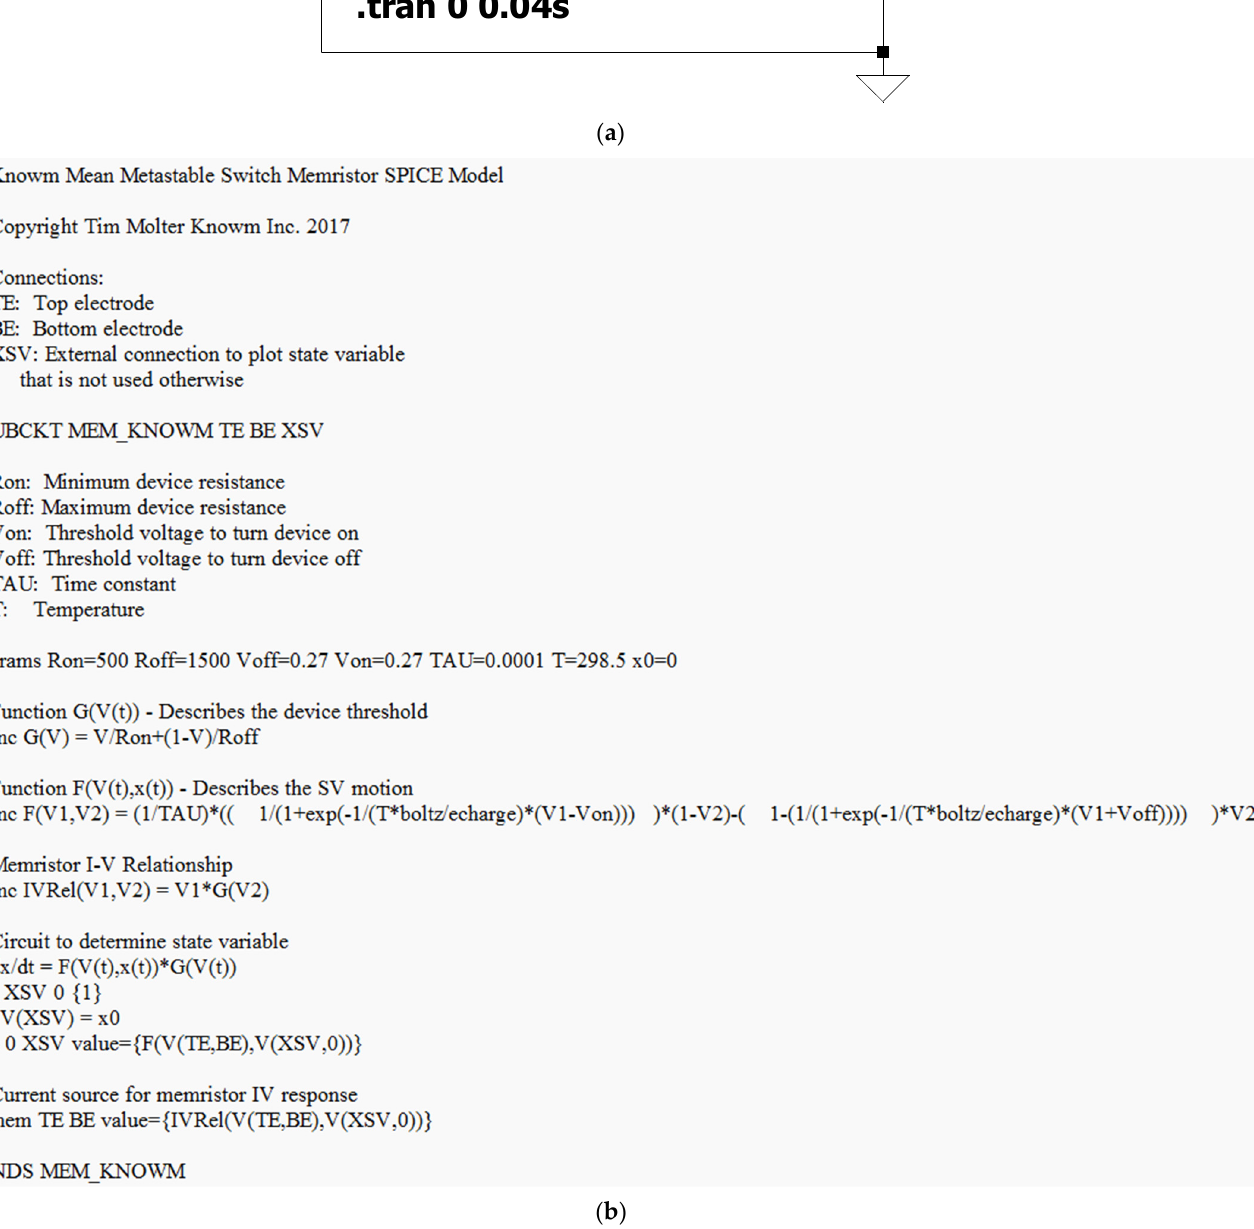
Figure 2. Time domain simulation results: the curve above is the relationship between state varia- bles and time, the sine curve below is the input voltage waveform, and the other curve is the cur- rent waveform. 0ms 4ms